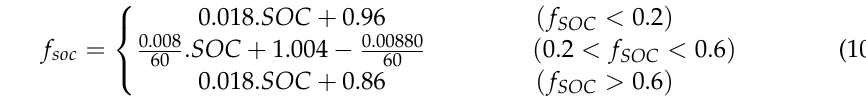
Figure 5. Layout of droop implementation.